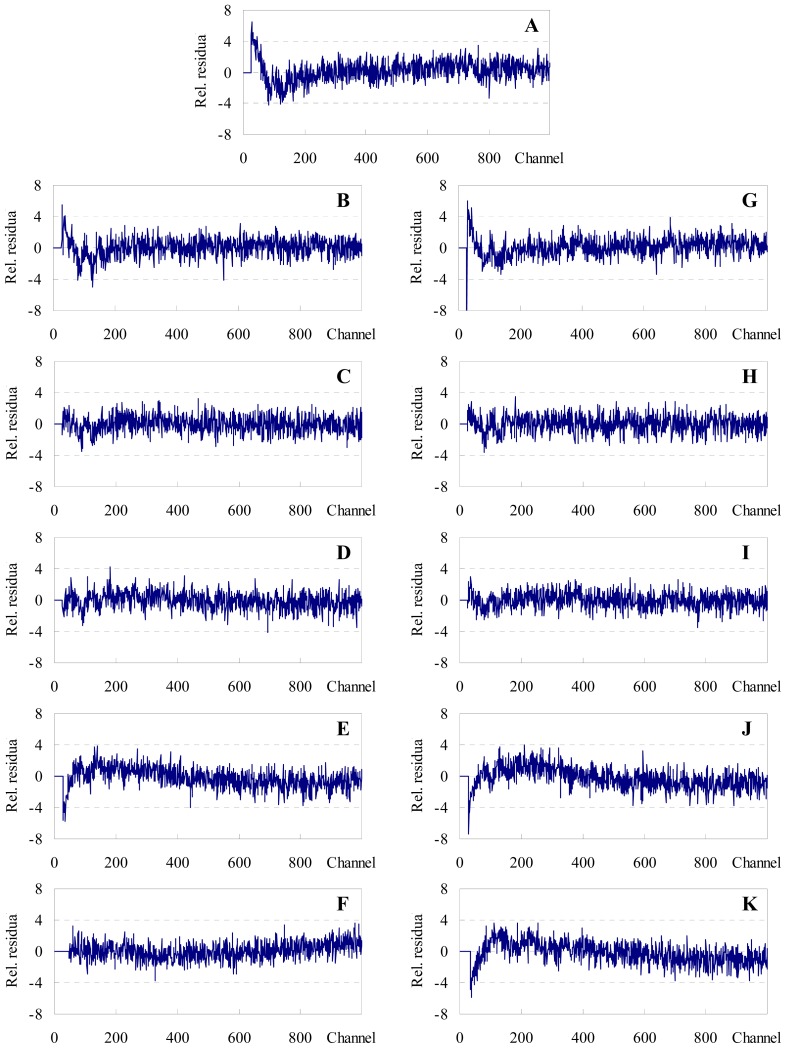
Residuals distributions of the fits shown in Figure 3. (A) no acceptor; (B–F): C6-NBD-PC acceptor, 0.040, 0.10, 0.24, 0.62 and 2.5 mol%, respectively; (G–K): C12-NBD-PC acceptor, 0.026, 0.065, 0.16, 0.41 and 1.6 mol%, respectively.